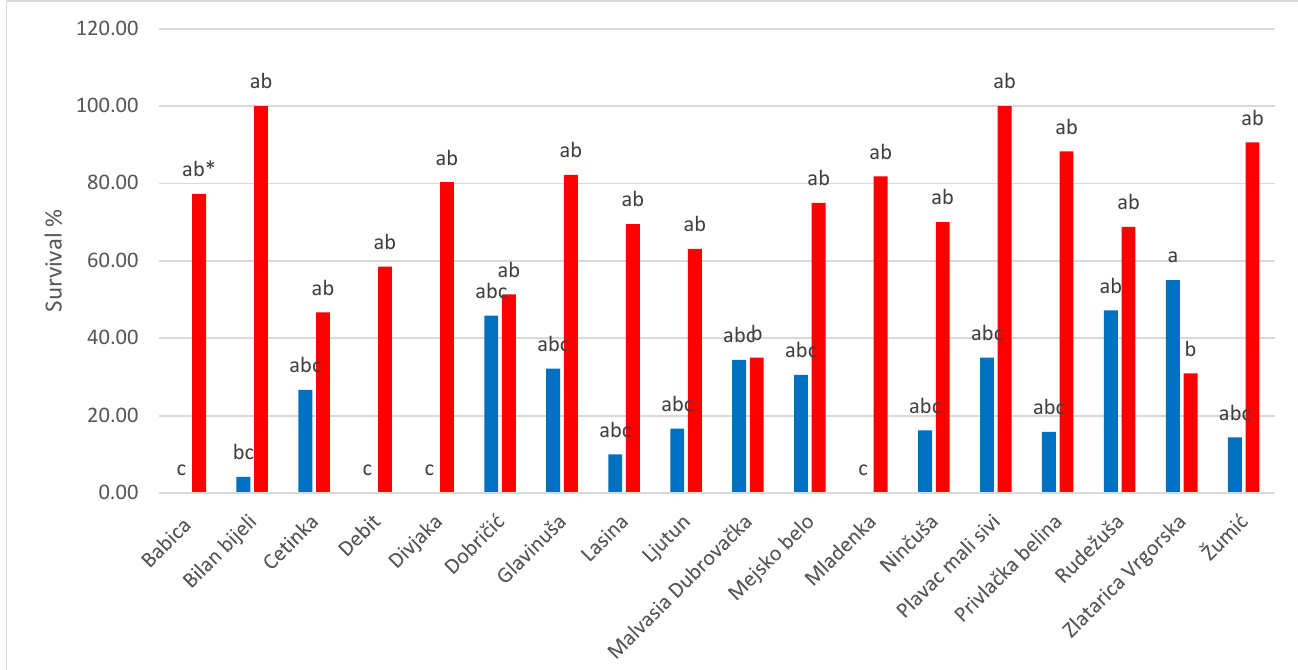
Figure 1. The survival of cultivars in two growth phases (before and after flowering). Blue columns represent the growth phase before flowering, and the red columns represent the growth phase after flowering. * Different letters represent significantly different values among cultivars within growth phase according to Duncan ’ s test, p ≤ 0.05.